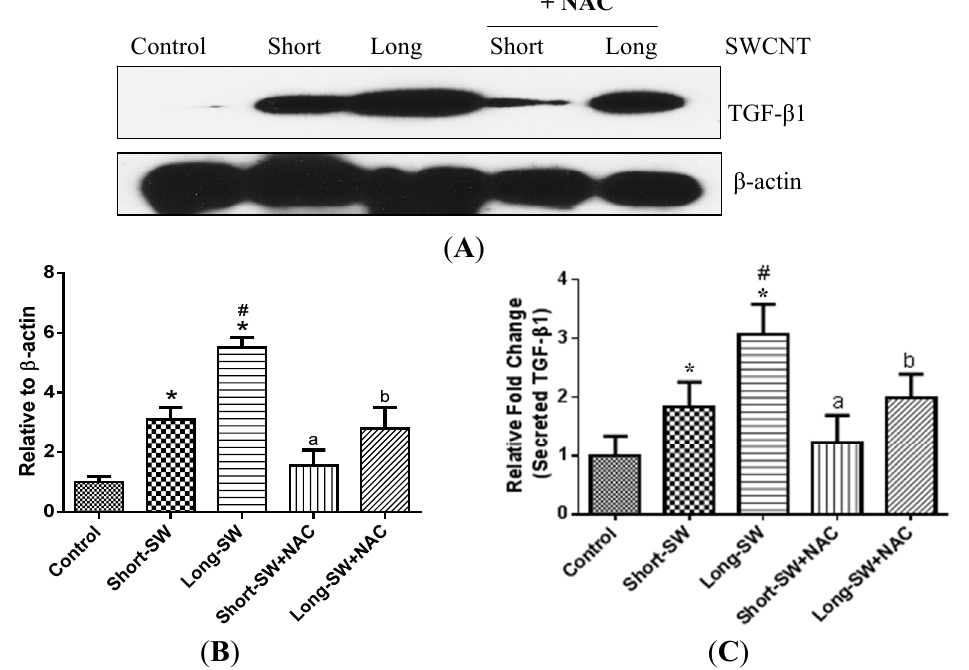
Figure 4. Effect of ROS on SWCNT-induced TGF- β expression. ( A ) Subconfluent cultures of NHLF were pretreated with NAC for 1 h and treated with SWCNT of different lengths at 0.06 µg/cm 2 and analyzed for TGF- β by Western blotting; ( B ) Protein quantification using Image J.; ( C ) Effect of NAC on secreted TGF- β levels in the treated cell supernatants measured by ELISA. Values are mean ± S.D. ( n = 3); * p < 0.05 vs. nontreated control; # p < 0.05 vs. Short-SW only; a, p < 0.05 compared to Short-SW only; b, p < 0.05 compared to Long-SW only.